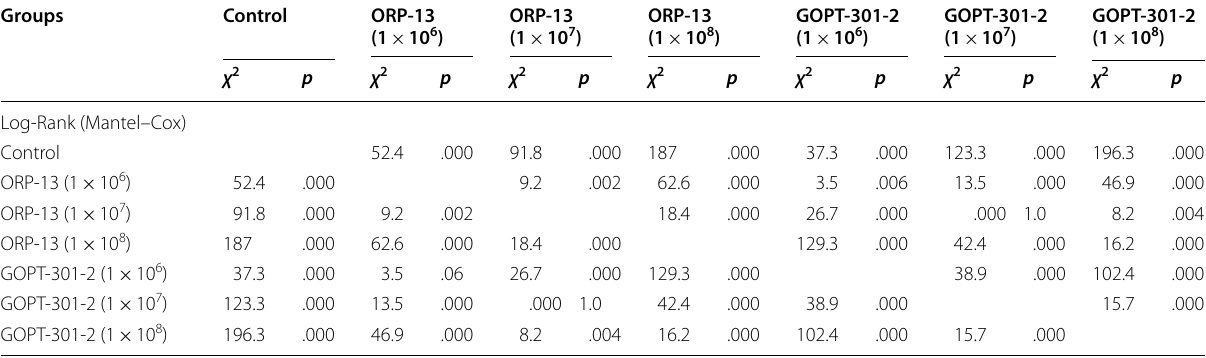
Table 4 Log-Rank (Mantel–Cox) test results of Malacosoma neustria larvae exposed to different concentrations of ORP-13 and GOPT-